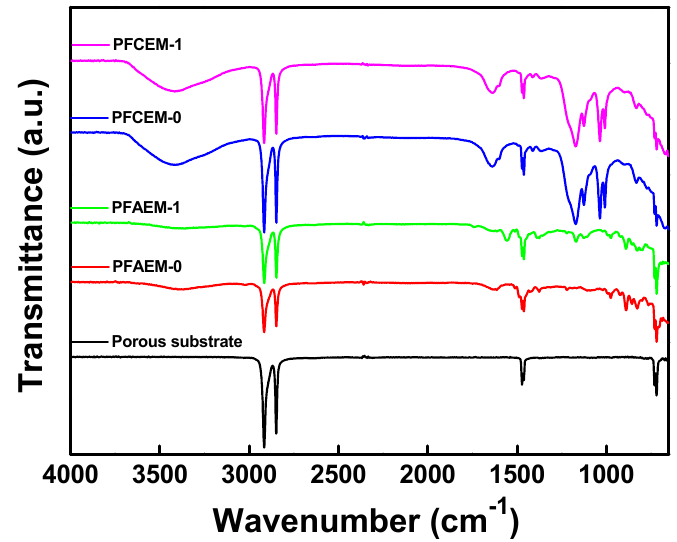
Figure 6. FTIR spectra of porous substrate, PFAEMs, and PFCEMs.